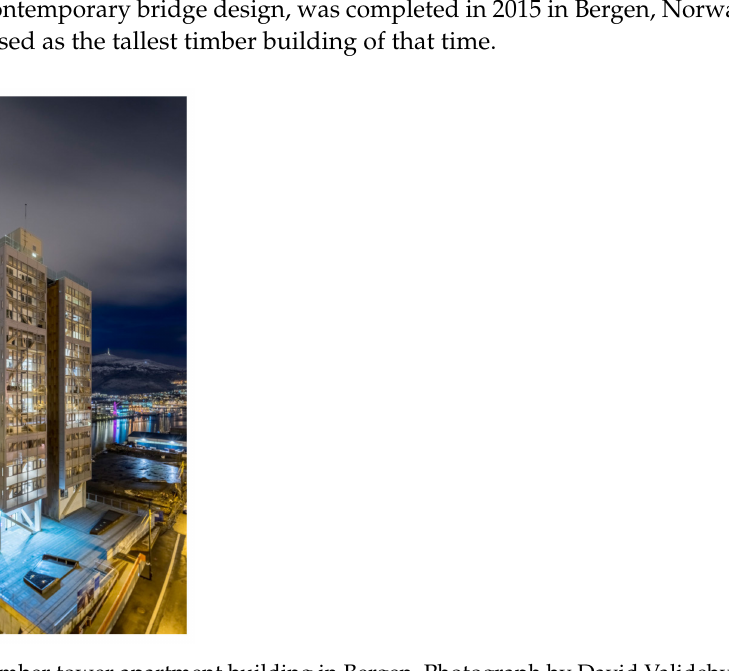
Figure 5. Treet—timber tower apartment building in Bergen, Photograph by David Valideby